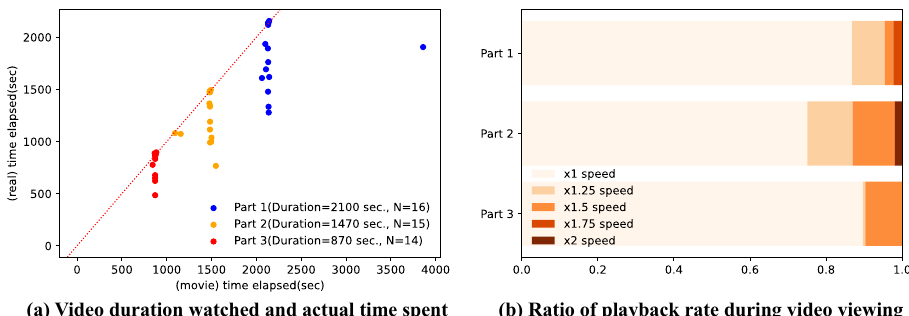
Figure 5. Example of collecting video viewing behaviors: In the examples of data analysis of video viewing behavior above, ( a ) shows the relationship between the duration of the video watched and the actual time spent watching the video, and ( b ) shows at what playback speed the video was played as a percentage of the elapsed time in the video. The figure shows that many subjects used the seek function or playback speed change function to watch the video in a shorter time than the actual time.